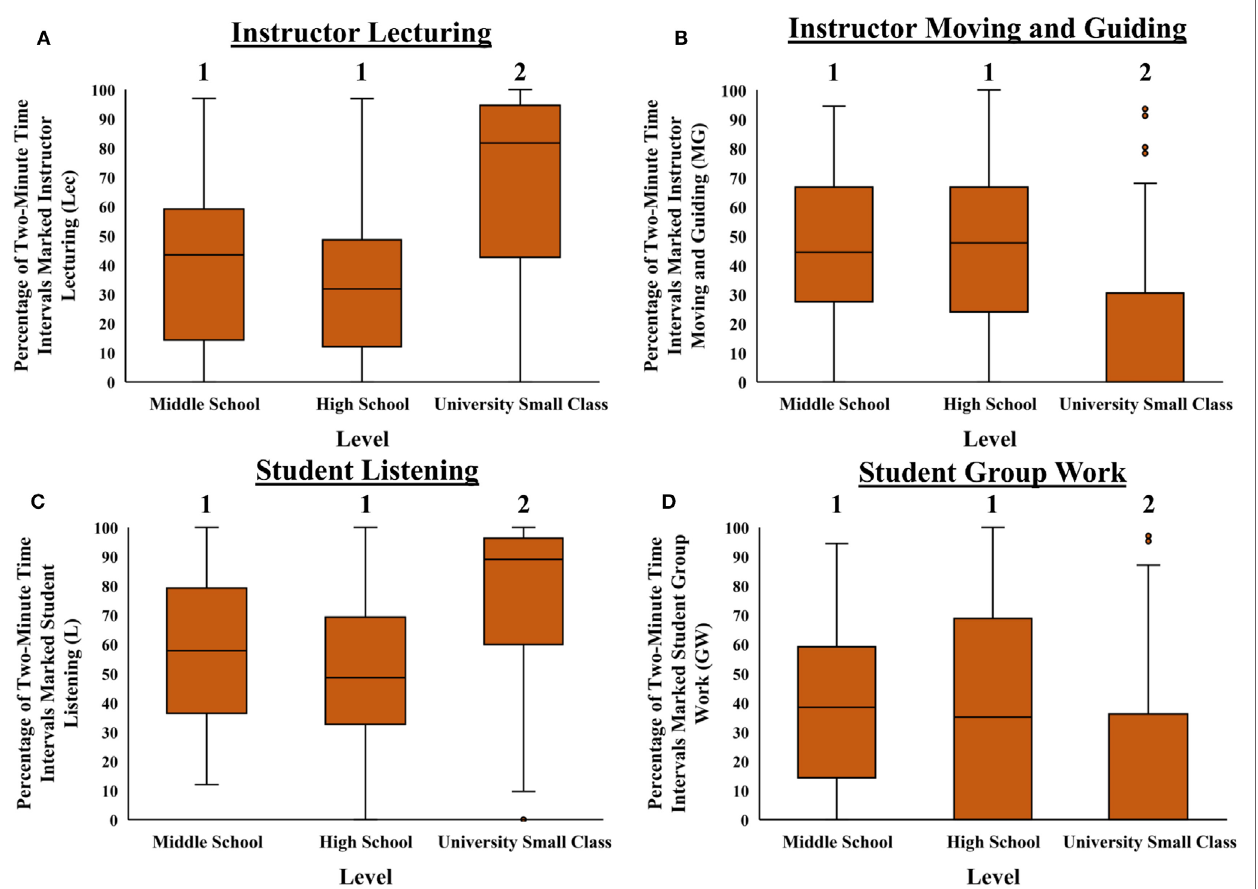
FigUre 10 | Comparison of the relative frequency of four Classroom Observation Protocol for Undergraduate STEM codes (a) Instructor Lecturing (Lec), (b) Instructor Moving and Guiding (MG), (c) Student Listening (L), and (D) Student Group Work (GW) for middle school, high school, and university classes with fewer than 30 students. Box-and-whisker plots showing the median and variation between the four instructional levels. The line in the middle of the box represents the median percentage of 2-min time intervals for the class sessions in each level. Boxes represent the interquartile range, whiskers represent 1.5 times the interquartile range, and data points not included in 1.5 times the interquartile range are shown with dots. Levels labeled with different numbers indicate a significant difference in mean ranks by a post hoc Dunn’s pairwise comparison (Kruskal–Wallis Test, Instructor Lec χ 2 = 43.28, Instructor MG χ 2 = 52.35, Student Listening χ 2 = 40.23, Student GW χ 2 = 18.59, df = 2, N = 192, p < 0.001 in all cases; Dunn’s pairwise comparisons, p < 0.001 for levels labeled with different